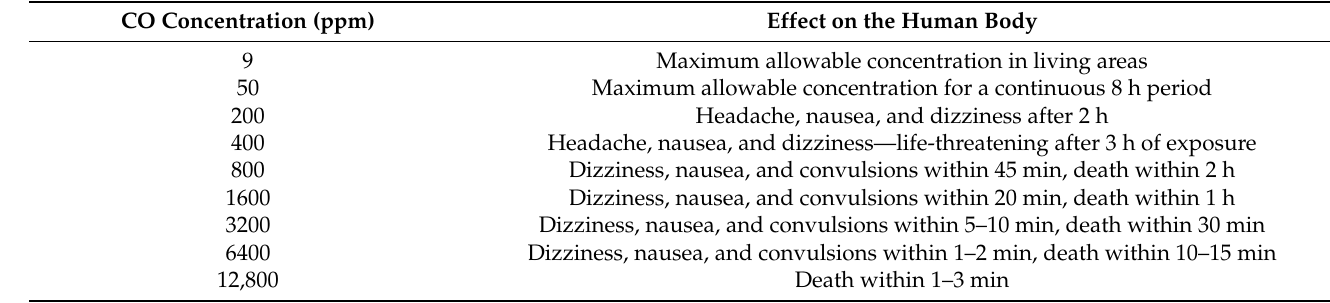
Table 1. CO concentrations and their effect on the human